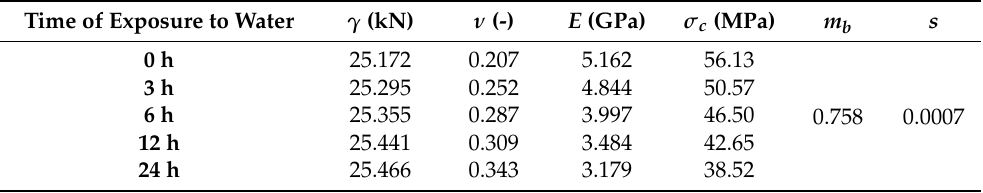
Table 5. Geomechanical parameters of claystone from beneath the D-2 roadway floor, depending on time of exposure to